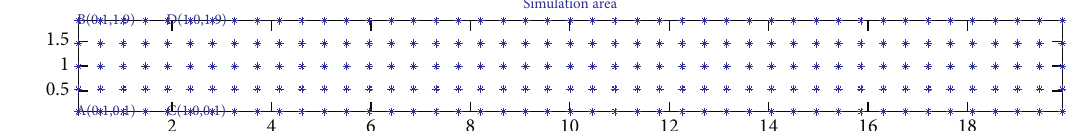
Figure 7: The entire simulation area.